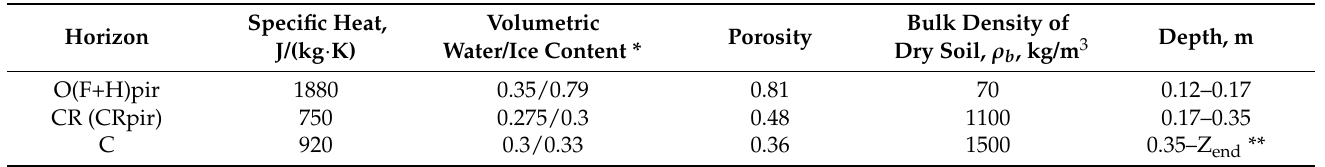
Table 2. Input parameters used for numerical simulation of the temperature regime in the soil profile. Physical characteristics of disturbed soils (post-fire and technogenic impact), summarized from the works in [49,50,56–59].